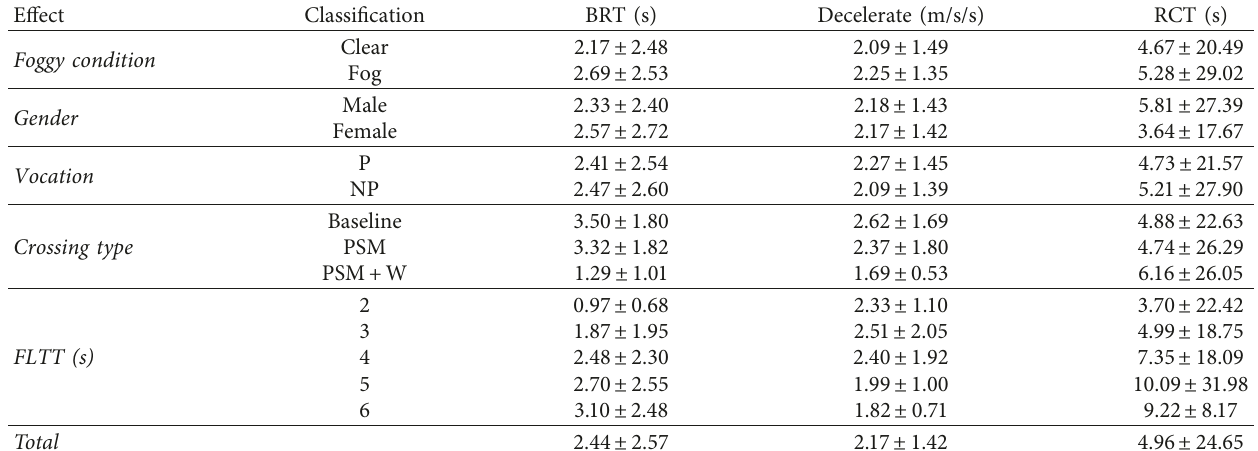
Table 4: Mean driving performance within different categories of factors.